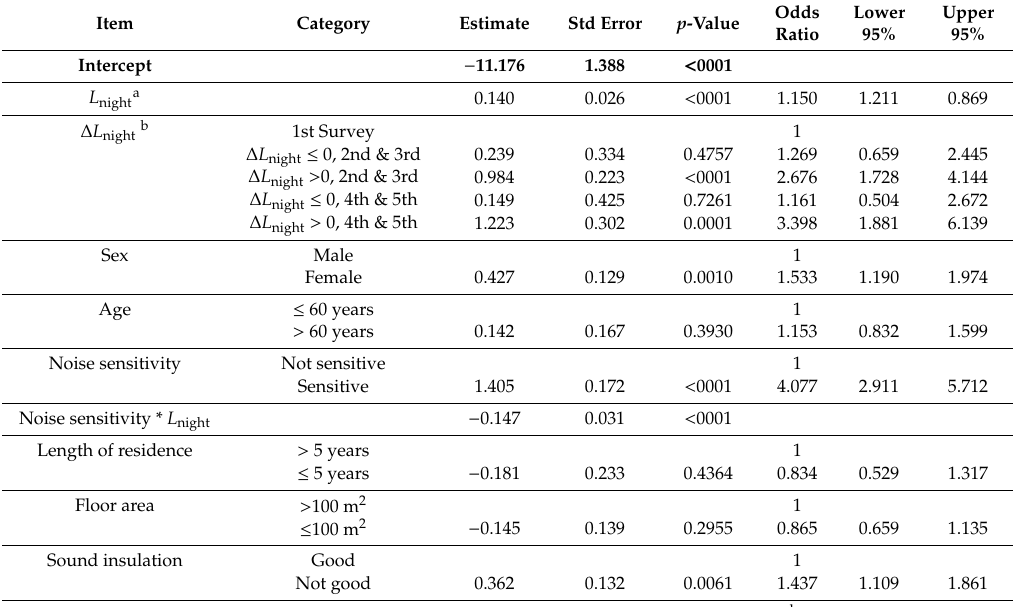
Table 8. Multiple logistic regression for insomnia (Generalized R 2 : 0.1516; AUC: